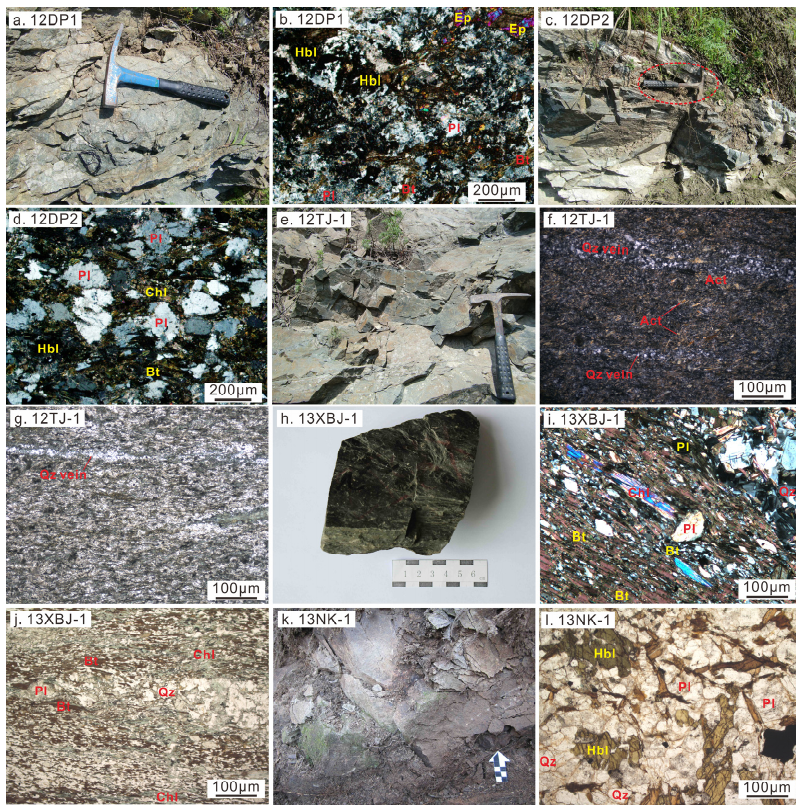
Figure 3. Field photographs and photomicrographs showing representative metamorphic rocks from the KYTM and HLTM. ( a , b ) Hornblende-epidote-plagioclase gneiss; ( c , d ) hornblende-biotite-plagioclase gneiss; ( e – g ) actinolite schist; ( h – j ) chlorite-hornblende-biotite schist; ( k , l ) biotite-hornblende leptynite. Mineral abbreviations according to the work in [85]. Plagioclase (Pl), quartz (Qz), biotite (Bt), hornblende (Hbl), actinolite (Act), epidote (Ep), chlorite